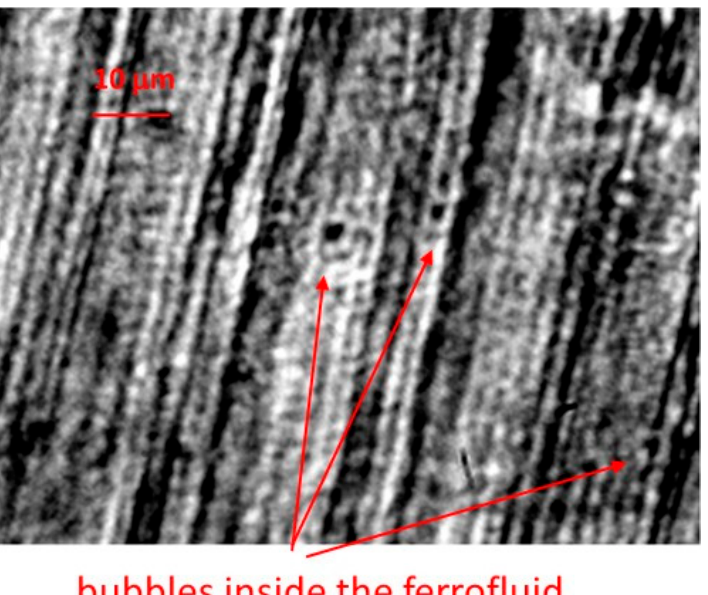
Figure 3. Photo of a ferrofluid-based self-assembled hyperbolic metamaterial [22]. The cobalt nanoparticle chains are formed inside the ferrofluid after application of external magnetic field. Several micron-scale bubbles inside the ferrofluid are indicated by arrows.